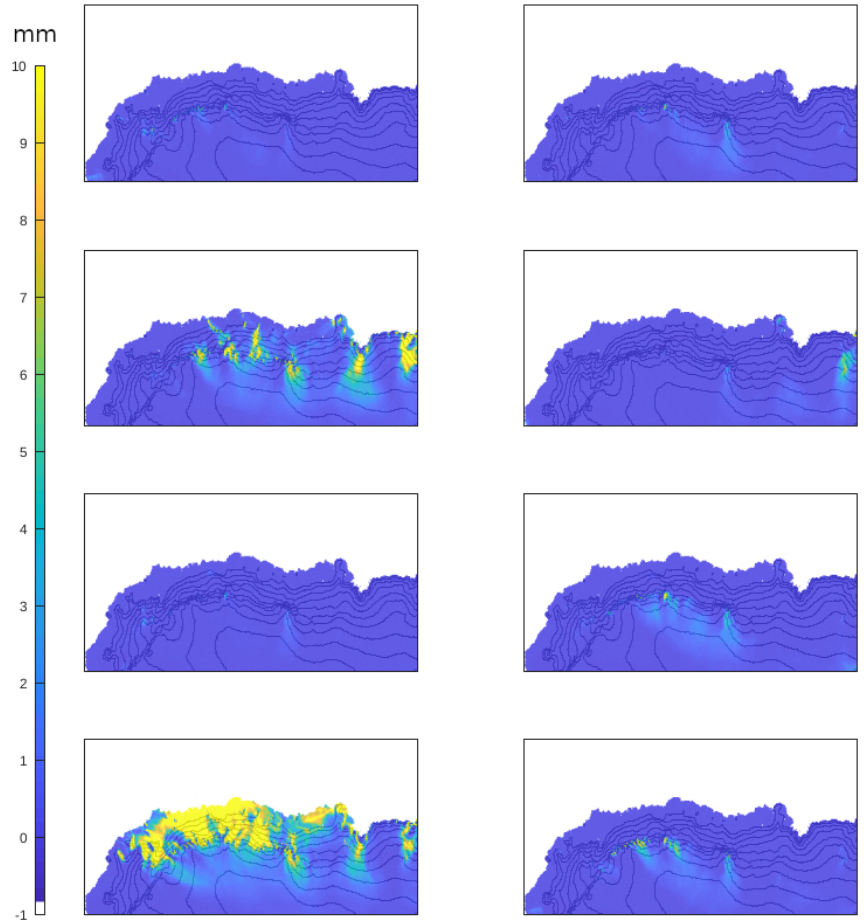
Figure 5. Recomposed maps of downscaled daily snowfall (mm) over DML on the first day of 1850 for members 1 to 8. A saturation at 10mm per day has been defined for